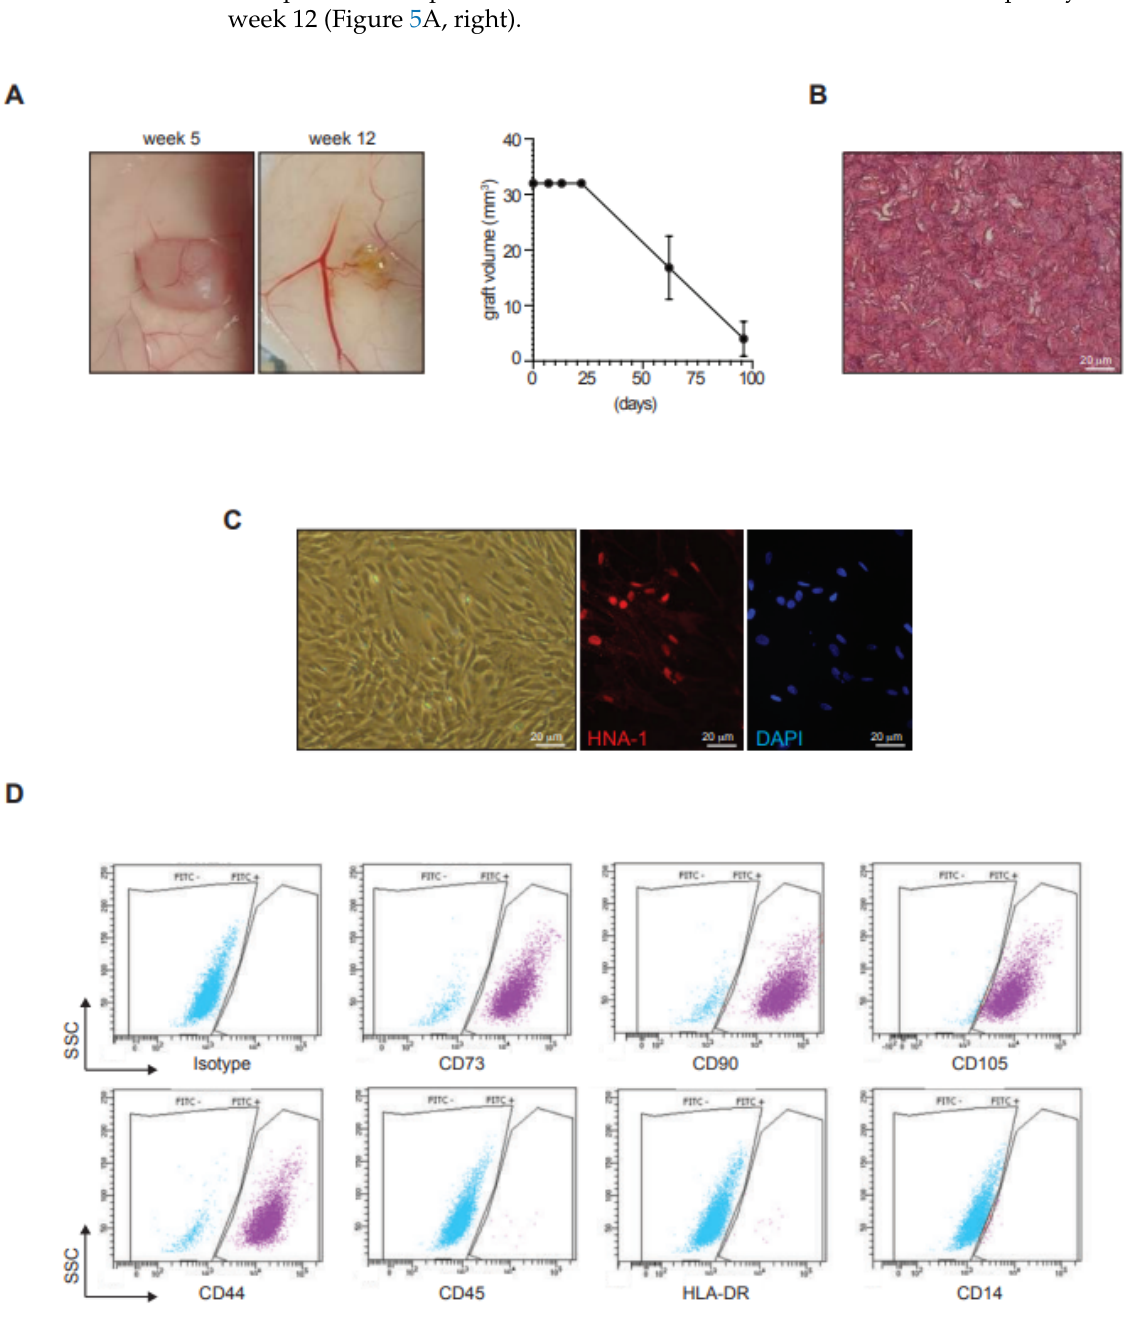
Figure 5. ASC-patches are stable in vivo after transplantation and do not show tumorigenicity. Ten Nu/Nu immunodeficient mice were transplanted subcutaneously with ASC-patches. Groups of 5 mice were sacrificed at weeks 5 and 12 for a macroscopic evaluation of transplants. ( A ) representa- tive images of transplanted ASC-patches at week 5 and 12 (left) and quantification of graft volume over time (right). ( B ) Hemalun/eosin coloration of a transplanted ASC-patch at week 5. ( C , D ) Cells were extracted after dissociation of grafted ASC-patches at week 5. ( C ) Representative images of the morphology (left), and Human Nuclear Antigen (HNA)/DAPI immunofluorescence (middle and right) of the cells extracted from the transplanted ASC-patches. ( D ) representative flow cytometry analysis of the extracted cell line for the indicated ASC markers (positive: CD73, CD90, CD105; negative: CD45, HLA-DR,